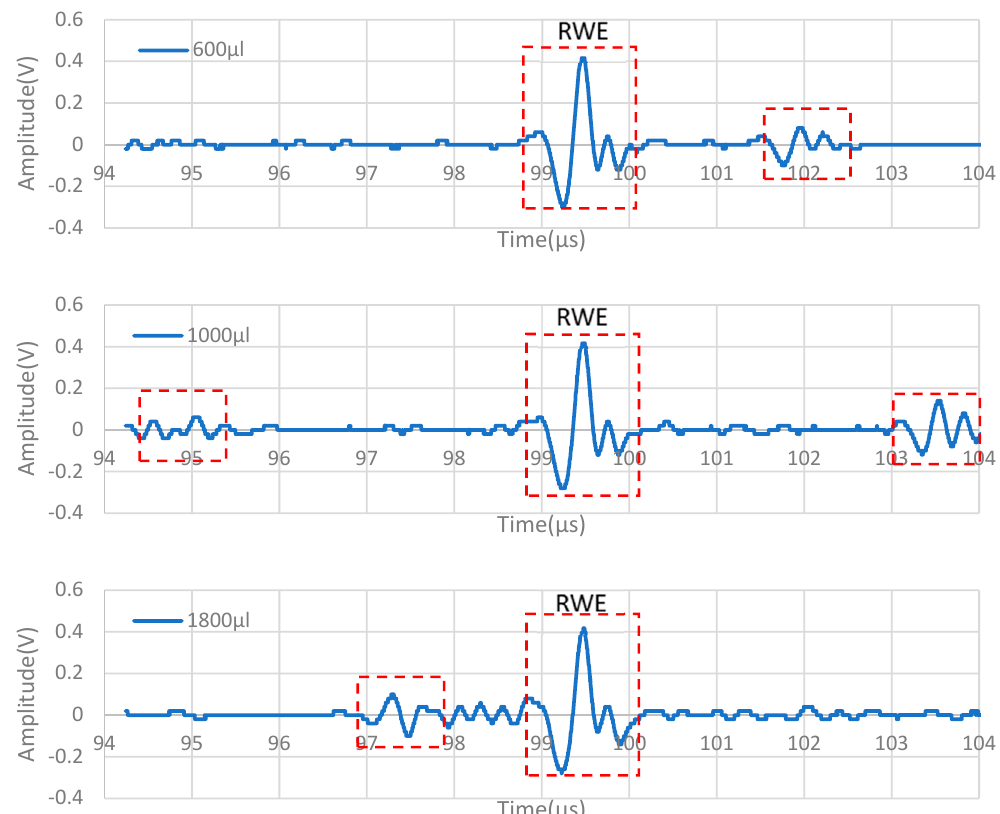
Figure 5. Time domain response for the reflected wave from the edge for all cases.